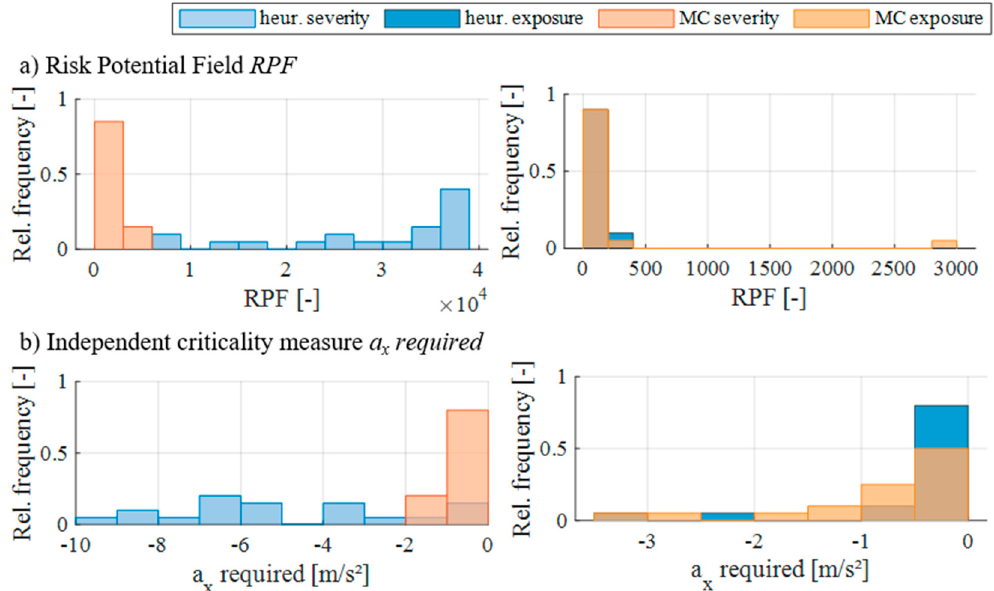
Figure 4. Results of criticality evaluation for severity test suite ( left column) and exposure test suite ( right column) of the heuristics (heur.), in comparison to the Monte Carlo (MC) simulation results, based on two different criticality measures: risk potential field ( a ) and required VuT deceleration ( b ).